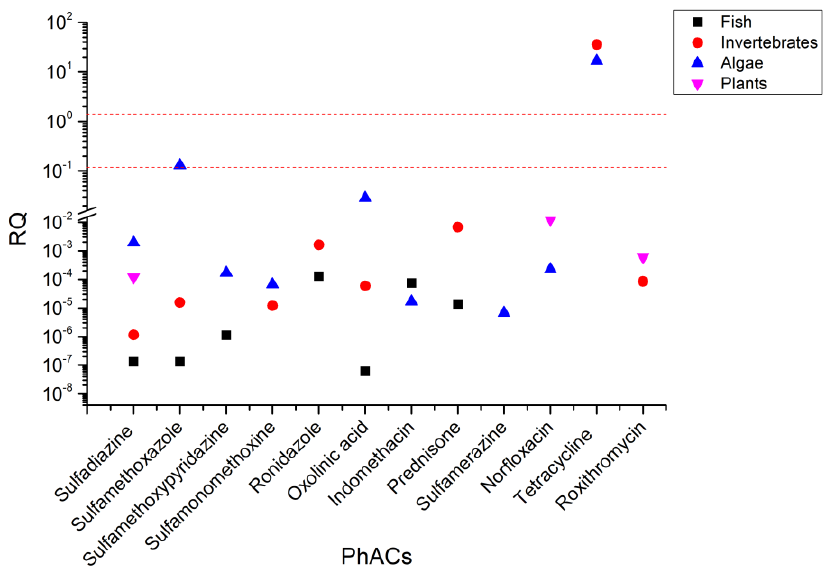
Figure 6. Risk quotients (RQs) for the PhACs detected in the surface seawater of JZB.